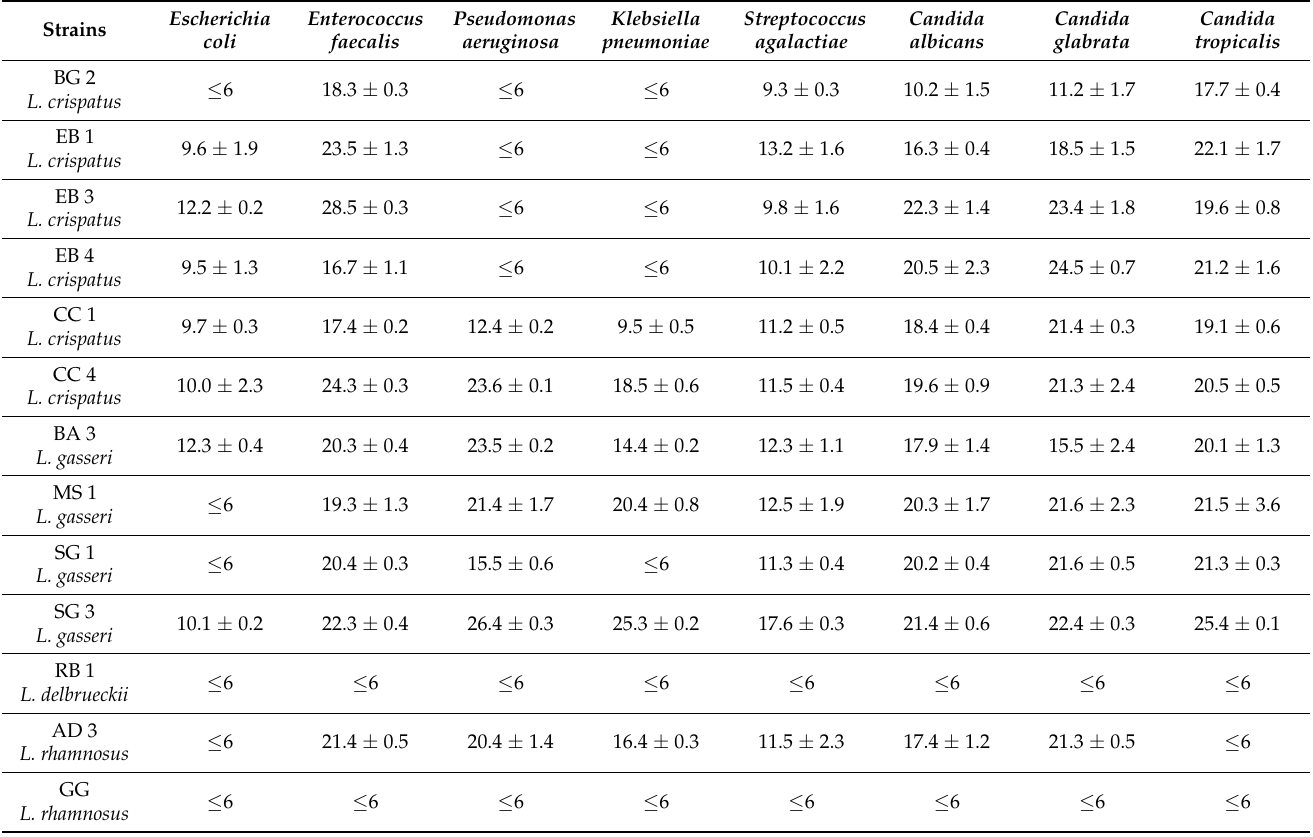
Table 2. Antimicrobial activity of cell-free supernatants produced by Lactobacillus strains against bacterial and fungal urogenital pathogens. Results were expressed in mm (mean ± SD). Escherichia Enterococcus Pseudomonas Klebsiella Streptococcus Candida Candida Candida Strains coli faecalis aeruginosa pneumoniae agalactiae albicans glabrata